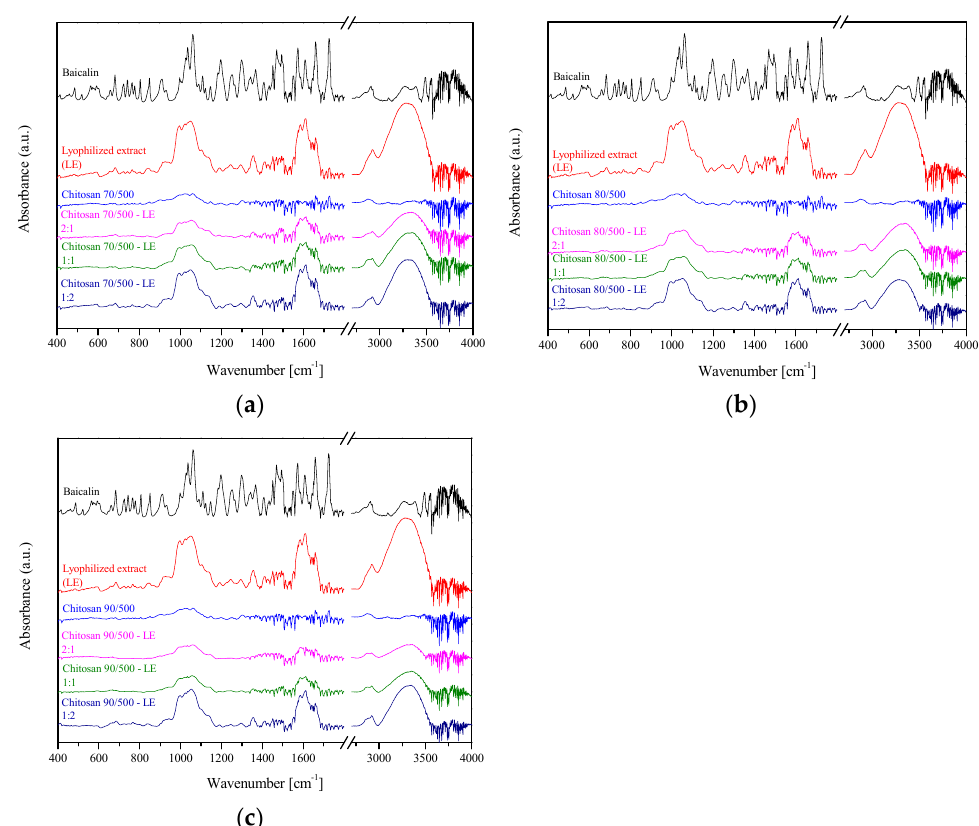
Figure 5. FTIR-ATR spectra of baicalin, S. baicalensis radix extract and its systems with chitosan 70/500 ( a ), chitosan 80/500 ( b ) and chitosan 90/500 ( c ). Characteristic bands of S. baicalensis lyophilized extract at 3330 cm − 1 , 1720 cm − 1 , and 1660 cm − 1 were connected with the stretching vibration of the O–H, –COOH, and C=O groups, where signals at 1600 cm − 1 and 1580 cm − 1 with the C=C vibration stretching of the aromatic rings in the structure of flavones. The broad bands in the range 1200–900 cm − 1 were connected to the various stretching vibrations of C–O bonds of saccharides [21]. Described wavelengths were also those characteristics of baicalin, the main active compound in the extract [35]. When analyzing spectra of chitosan, one can notice characteristic bands at 3360 cm − 1 and 3300 cm − 1 bands coming from stretching vibrations of O-H and N-H groups, at 2900 cm − 1 from C-H vibrations, and at 1650 cm − 1 from N-H vibrations. Spectra of chitosans with different degrees of deacetylation do not differ in terms of the position of individual bands. However, quantitative IR analysis may be used to characterize the exact degree of deacetylation [36]. Finally, when analyzing spectra for the systems, it can be observed that the spectra are the sum of the spectra for individual components such as lyophilized extract and chitosan. Thus, it can be concluded that the prepared systems are physical mixtures, and no changes in the chemical structure of the S. baicalensis extract occurred after the system preparation process. Therefore, it is the method of preparing the system that has a decisive impact on the formation of connections between the components, and grinding leads to the formation of only a physical mixture [21], while in the case of other preparation methods, ATR spectra may indicate interactions between the extract and chitosan [22].